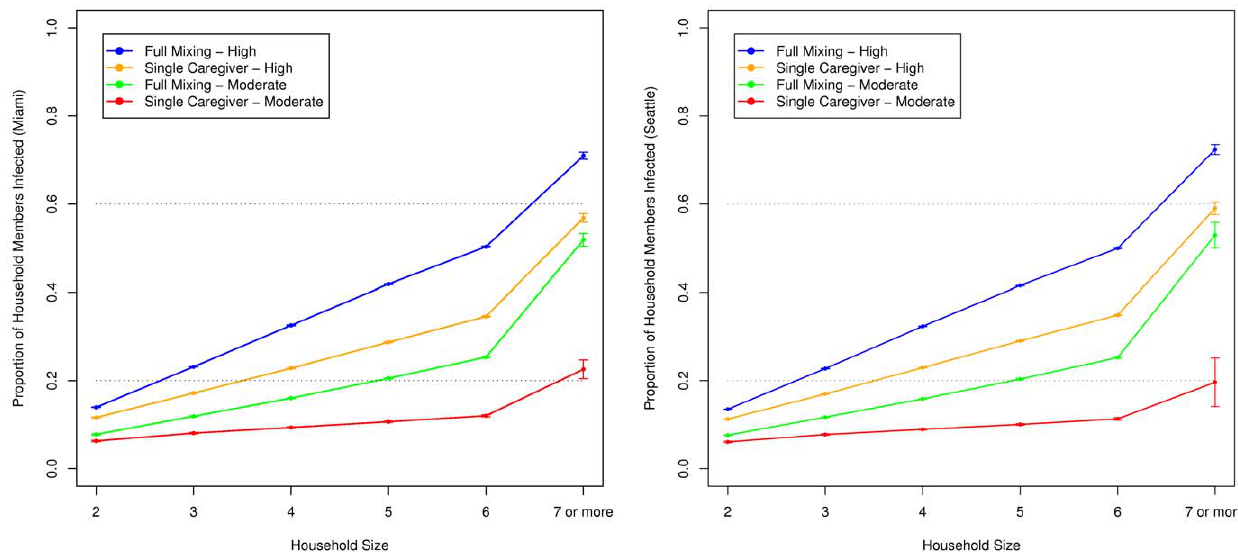
Figure 4. Proportion of the household infected vs. the household size. Left: for Miami ; right: for Seattle . Households of size 7 and higher have been aggregated into one data point. As Table 1 shows, households of size 7 and higher constitute less than 3% of Miami households and 1.2% of Seattle households. The proportion of infected members in the household increases with the household size and is higher for the full mixing structure than for the single caregiver structure in both cities. The difference in proportion due to household structure also increases with household size; more so when the infectiousness is moderate.